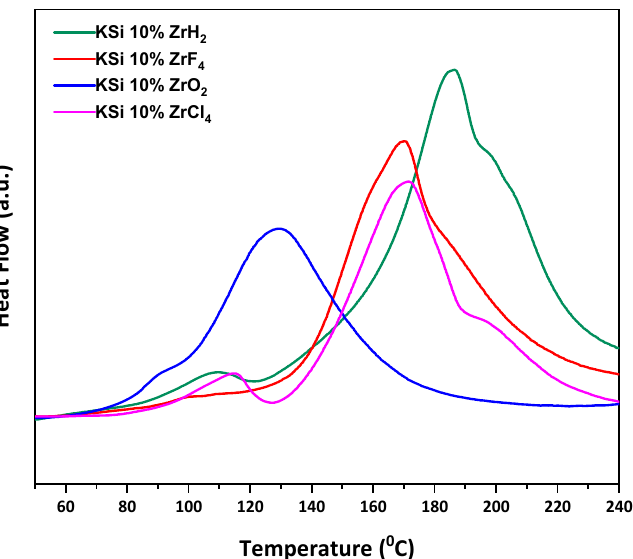
Figure 3. DSC profile of catalyzed KSi systems under 5 MPa H 2 at heating rate 5 °C/min.